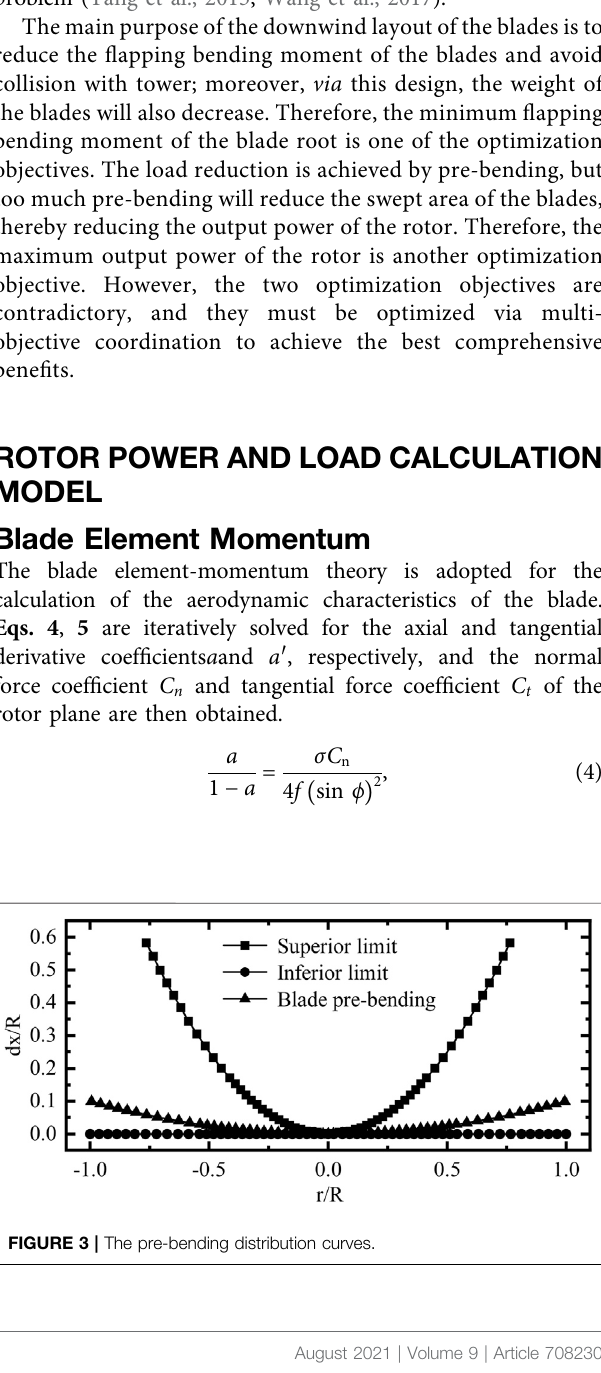
FIGURE 2 | The twist angle distribution curves.